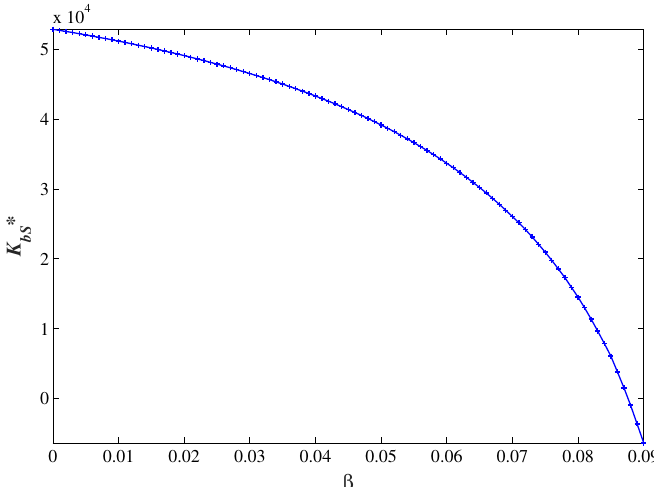
Figure 6. Optimal security investment allocation to branches over the benefited rate of security information